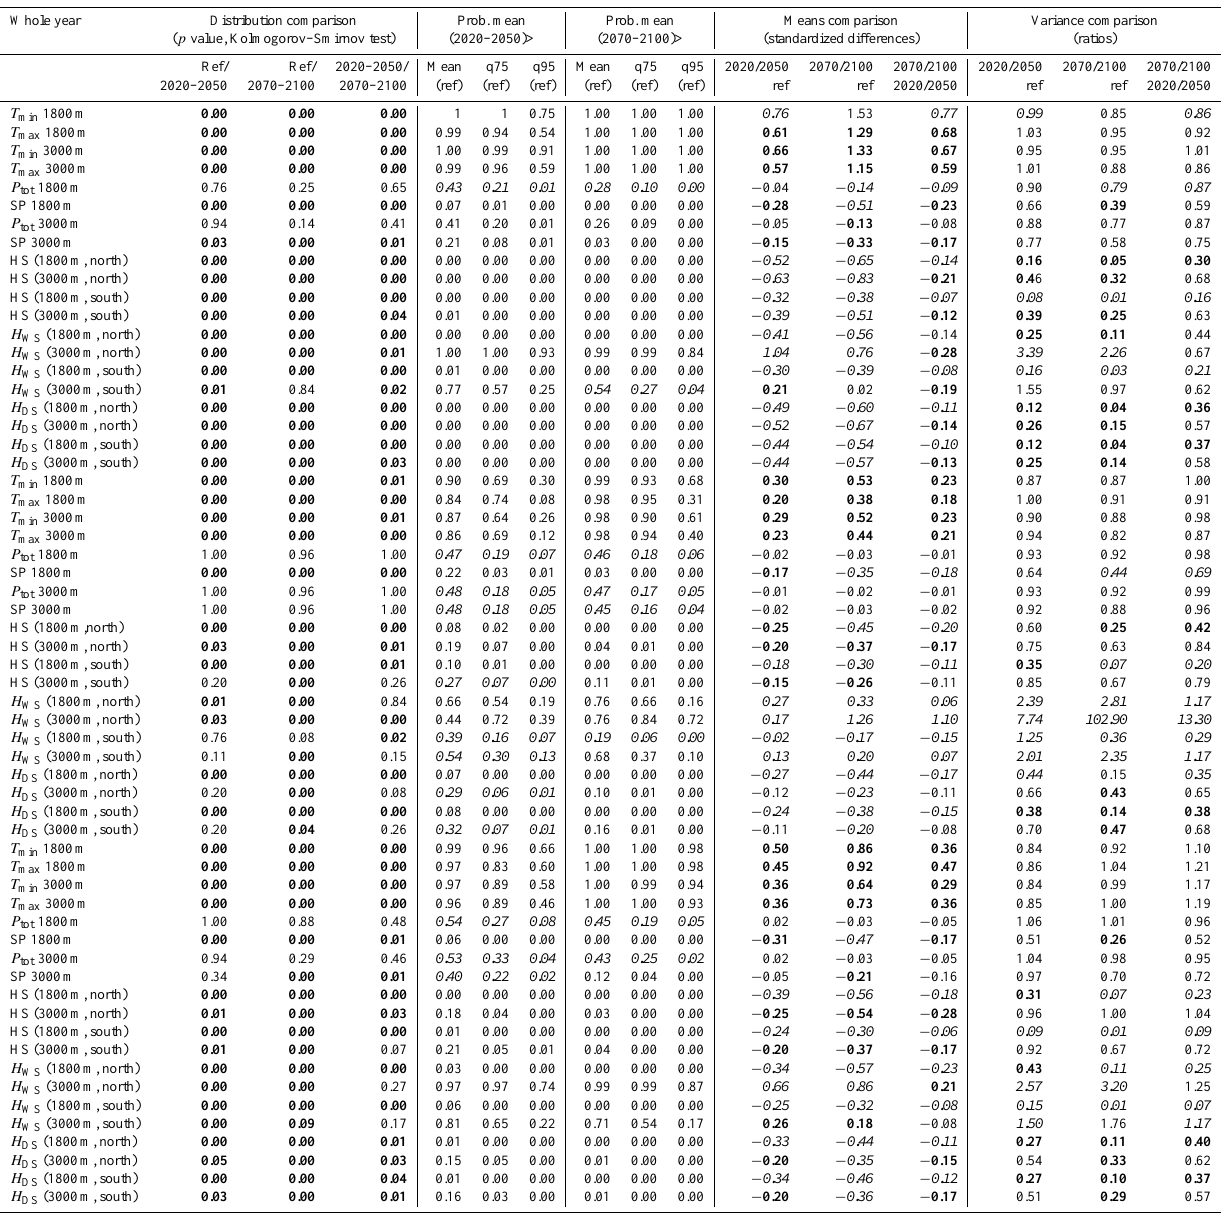
Table 5. Changes in meteorological and snow variables between the reference period and the two future periods for the entire French Alps during the whole year and during the winter and the spring periods. “Ref”, 2020–2050 and 2070–2100 correspond, respectively, to the three considered periods – the reference period (1960–1990) and the mid and end of the 21st century. The probability for a future year to be higher than the reference mean and the 75 and 95% percentiles of the reference distribution is quantified, as are ratios and differences between the reference variance/mean and the two future variances/means. For the Kolmogorov–Smirnov test, bold values indicate different samples at the 0.05 significance level. When the null hypothesis of similar underlying distributions is not rejected, exceedance probabilities appear in italic, as differences with the reference period may be insignificant. When the assumption of a Gaussian distribution is rejected for at least one of the considered samples, the significance of the variance comparison cannot be tested so that the variance ratios appear in italic. When the assumption of Gaussian distributions with similar variances is rejected for at least one of the considered samples, the significance of the mean comparison cannot be tested so that the mean standardized difference appears in italic. When the significance of variance/mean comparisons could be tested, ratios/standardized differences rejecting the null hypothesis of equality are shown in